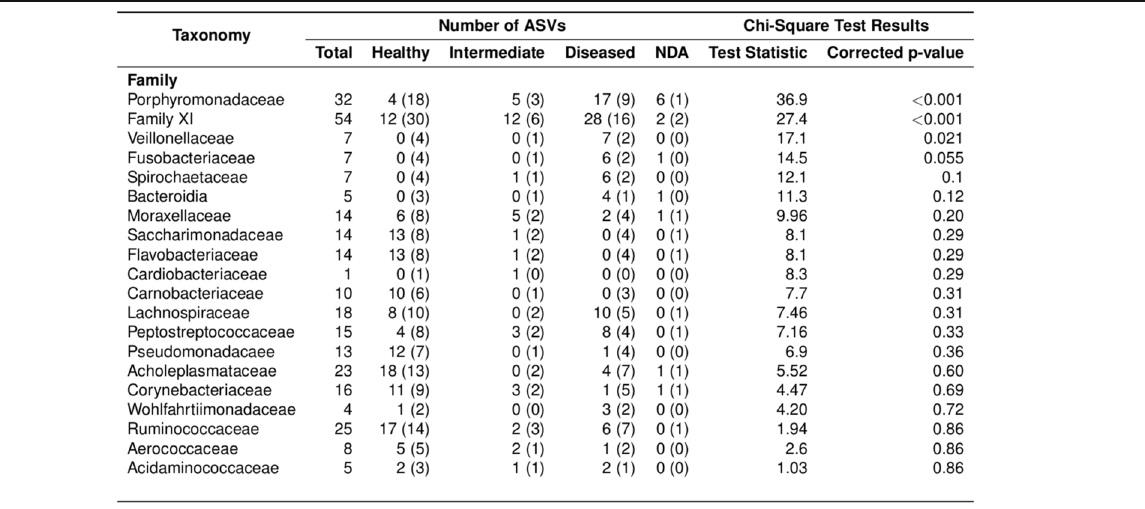
Table 1 Taxonomic divisions containing ASVs identified as differentially abundant between Healthy, Intermediate and Diseased feet. Families which had either a significantly different distribution to the expected value or were most associated with one ASV group are shown. Expected distributions are displayed in